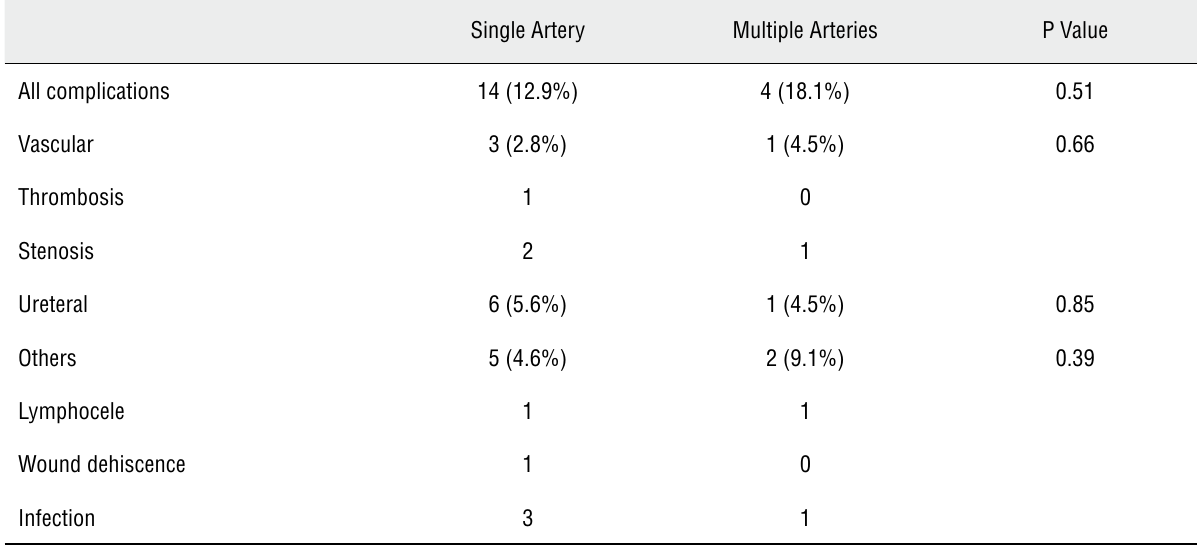
Table 3 - complication rates by